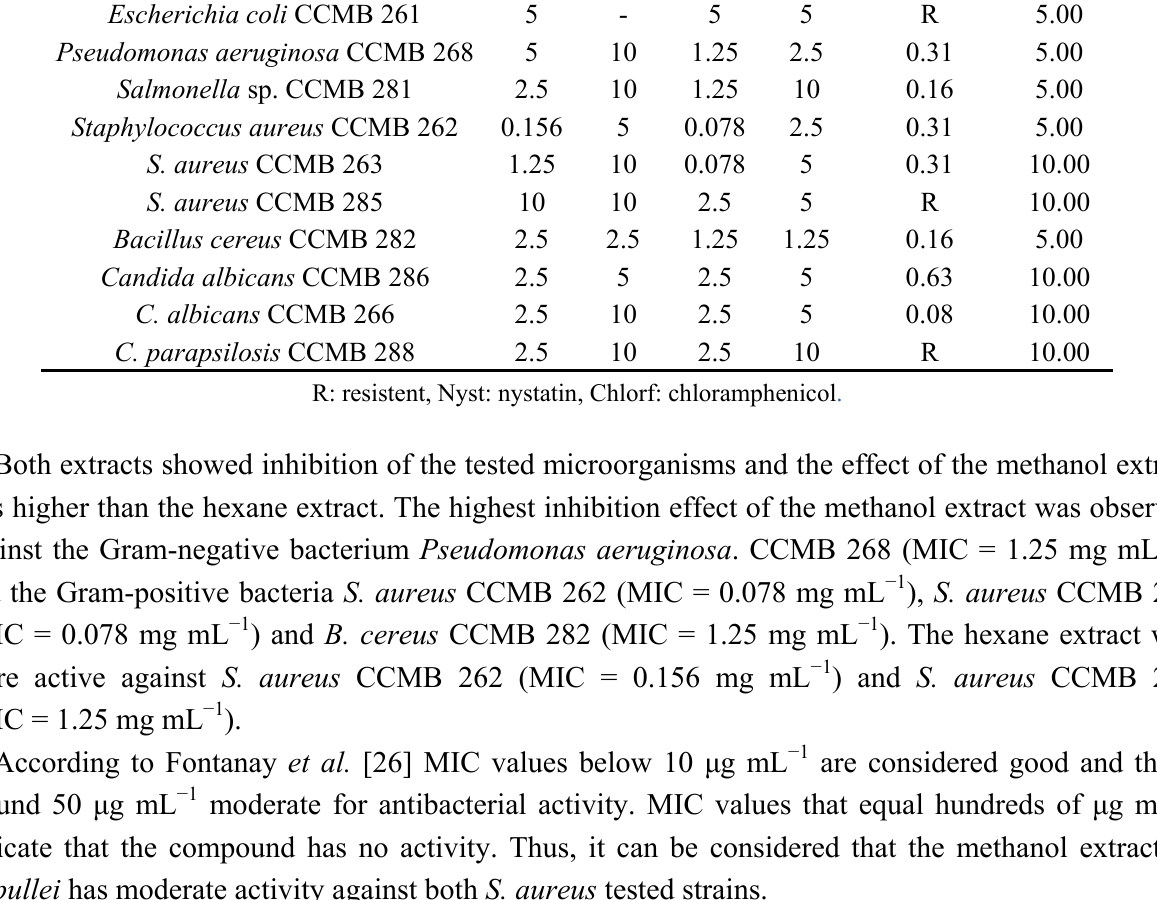
Table 3. Results of Minimum Inhibitory Concentration (MIC) and Minimum Microbicidal Concentration (MMC) in mg mL − 1 , of the hexane and methanol extracts of C. pullei stems. Hexane MeOH Control Organism MIC MMC MIC MMC Nist/Chlorf DMSO Escherichia coli CCMB 261 Pseudomonas aeruginosa CCMB 268 Staphylococcus aureus CCMB 262